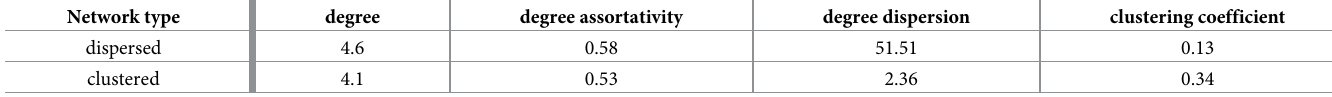
Table 1. Summary statistics of the two types of networks simulated. Quantities are averaged across 250 nodes and 50 stochastic replicates.